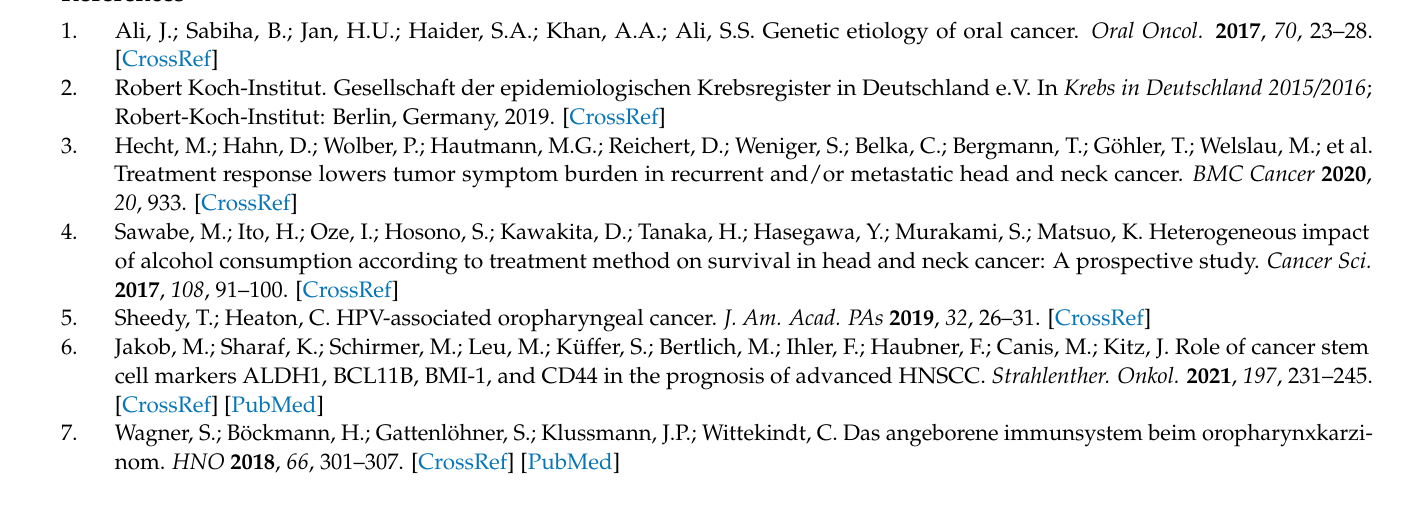
Randomized phase-III-trial of concurrent chemoradiation for locally advanced head and neck cancer comparing dose reduced